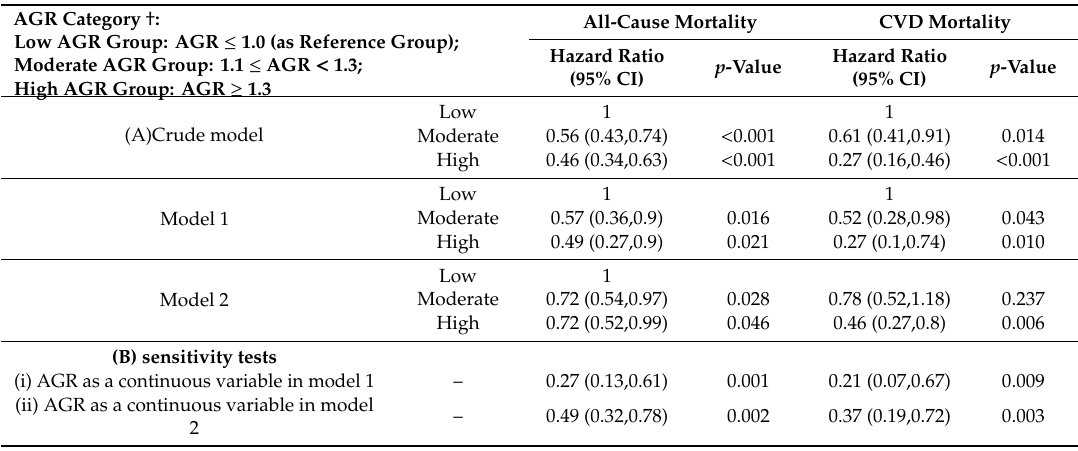
Table 3. Univariate and multivariate Cox regression models of all-cause and CVD-related mortality for AGR